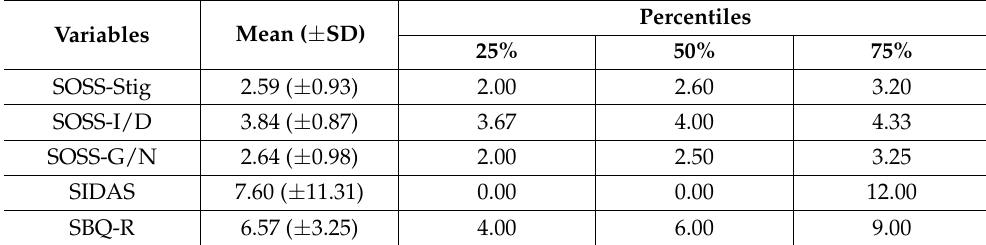
Table 2. Descriptive Statistics for the Scores on SOSS, SIDAS, and SBQ-R.